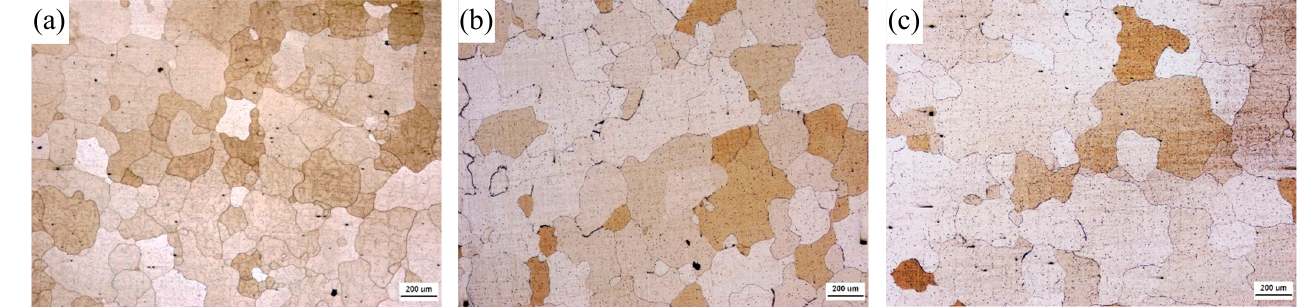
Figure 7. Optical images of the samples after solid solution treatment; ( a ) 1300 °C for 1 h, ( b ) 1300 °C for 3 h, ( c ) 1300 °C for 5 h.